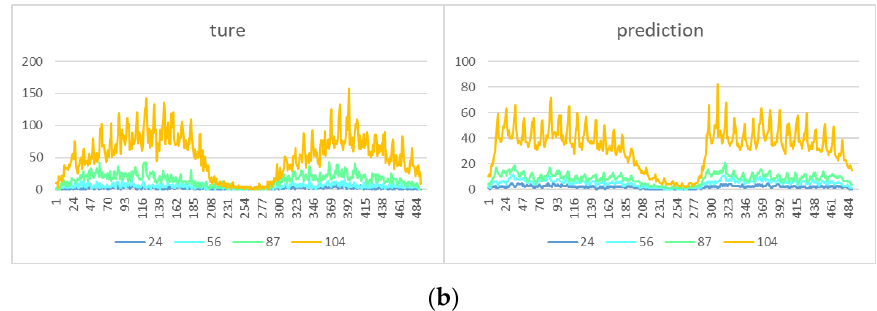
Figure 9. Comparison of continuous prediction results for single region number 24, 56, 87, and 104; ( a ) shows the predicted and actual values of the travel demand for four different types of areas (number 24, 56, 87, and 104) in 40 h; and in ( b ), the predicted and actual results of the four areas are summarized.